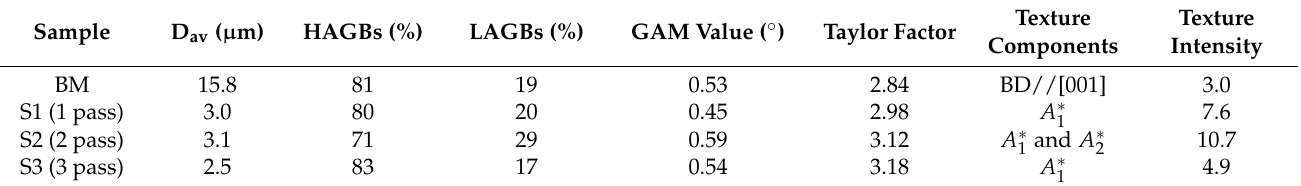
Table 2. EBSD data of the grain and texture characteristics in the BM and SZs. The data comes to the fine SZs as shown in cross-sectional macrostructures (Figure